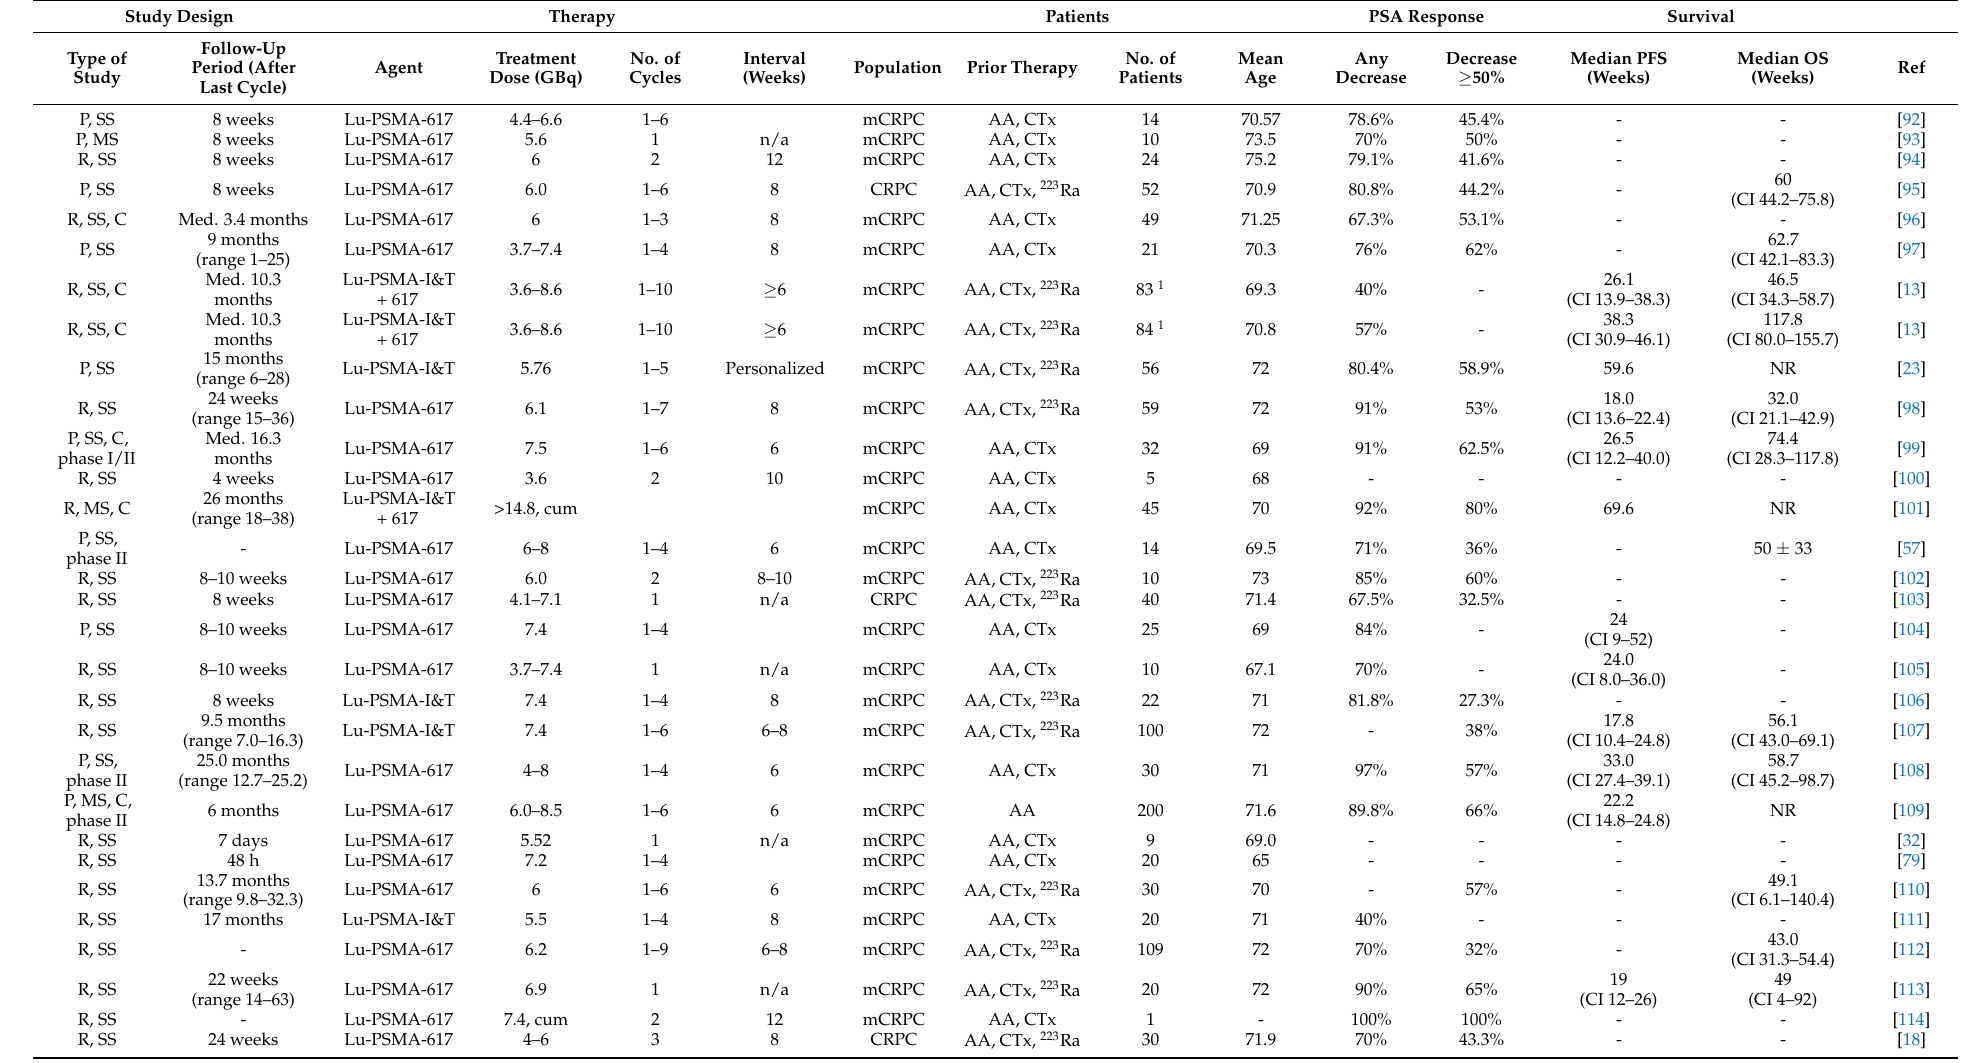
Table 1. Meta-analysis of all doses using published patient data and their respective PSA outcomes and survival